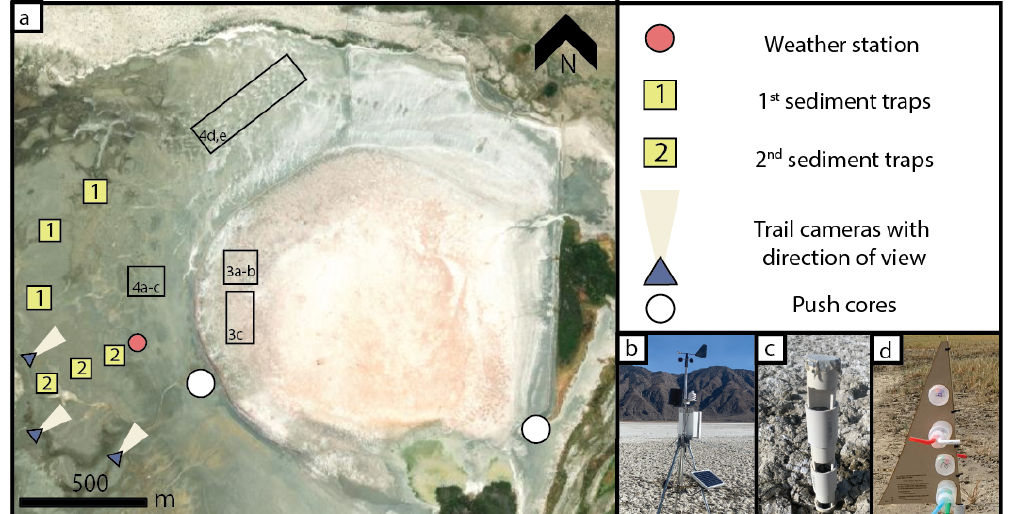
Figure 1. Study area and monitoring sites, Deep Springs, CA. (a) Extent of Deep Springs playa. Locations of other figures are boxed. Image courtesy of Google Earth (© Google Earth 2022). (b) Modular weather station indicated by red dot in (a) with data collected continuously between 1 May 2021–11 May 2022. (c, d) Sediment traps deployed from March 2020 to August 2020, indicated by the “1” in (a) , and October 2021 to May 2022, indicated by the “2” in (a)